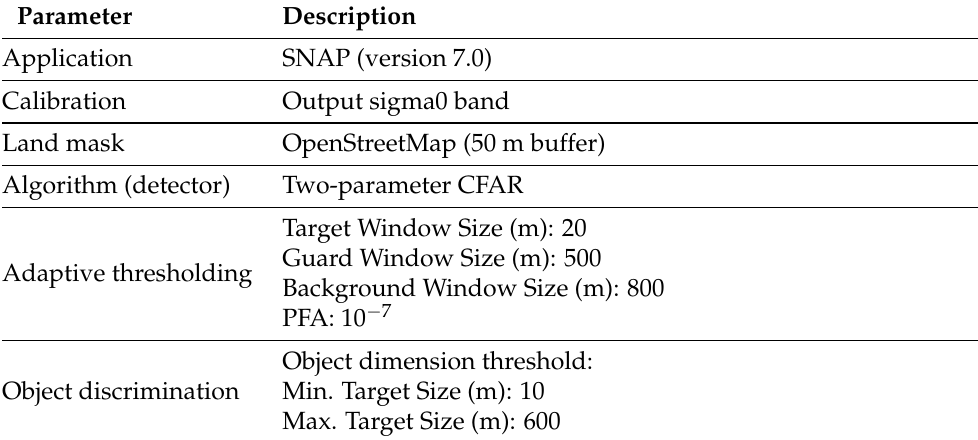
Table 9. SNAP: SAR processing